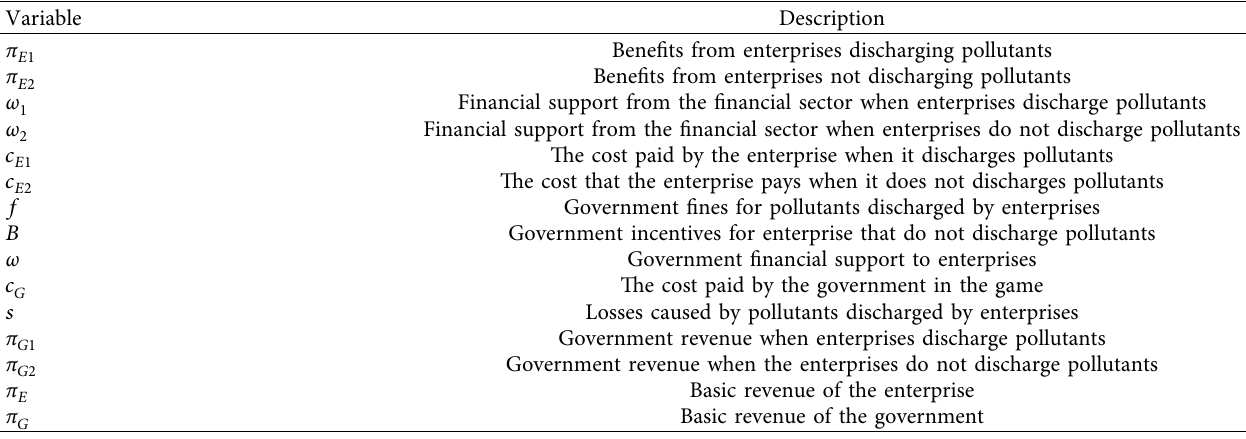
Table 1: Variable